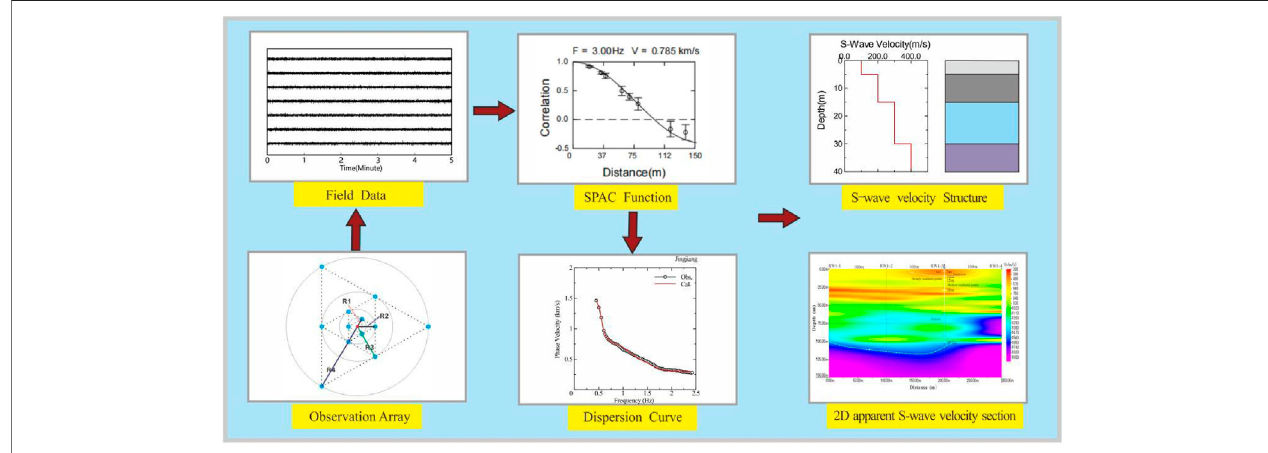
FIGURE 2 | Microtremor survey method (MSM) work fl